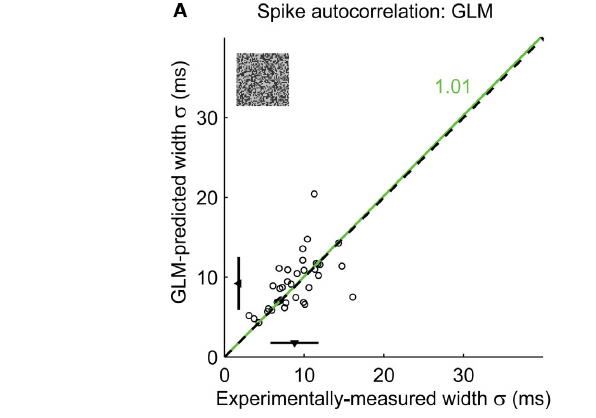
experimentally measured autocorrelation width and the model-predicted width using a least-mean-square fit on all data points. The mean ± standard deviation are represented along each axis by an arrowhead and bar. The model predictions are not significantly different from the experimental measurements (paired t -test: p = 0.36). (B) Same as (A) , but as predicted by the LNP model. The LNP model significantly overestimates the autocorrelation width (paired t -test: p < 10 − 12